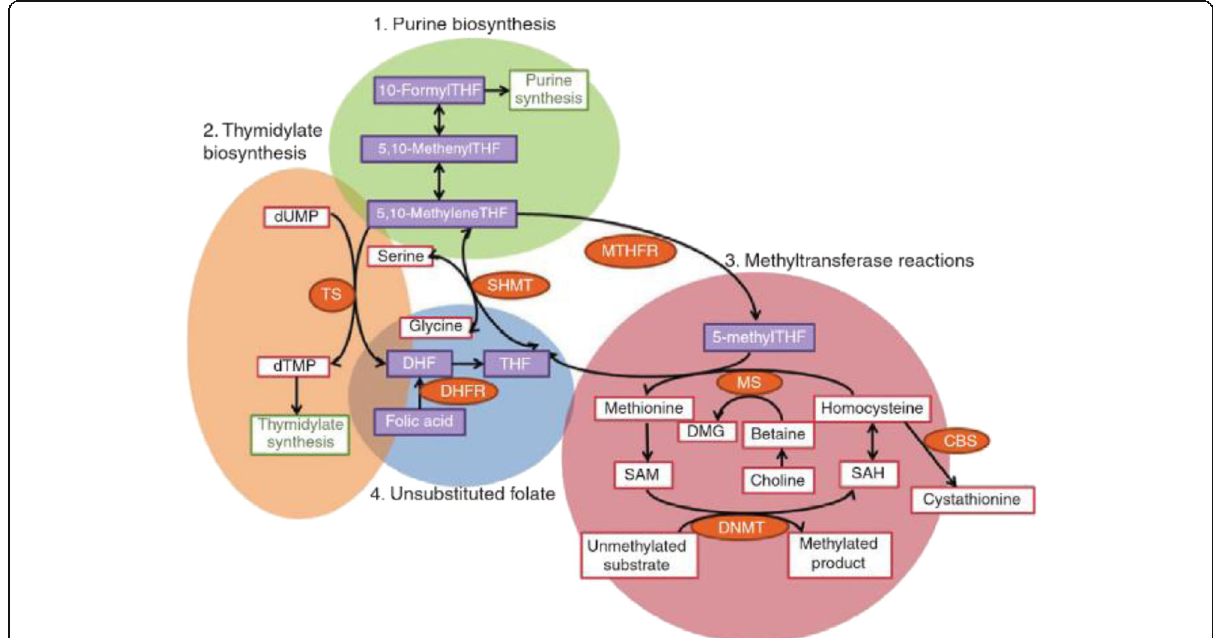
Fig. 2 Intracellular network of reactions in the metabolism of folates. A variety of related compounds derived from folic acid have specific biochemical functions. Folic acid is first converted into dihydrofolate ( DHF ) and subsequently into tetrahydrofolate ( THF ) by the enzyme DHF reductase ( DHFR ). 5,10-methyleneTHF and 10-formylTHF are responsible for the synthesis of purines; 5,10-methyleneTHF also mediates the conversion of dUMP to dTMP for the synthesis of thymidine, catalysed by the enzyme thymidine synthase ( TS ). 5-methylTHF is involved for methylation reactions, particularly in the conversion of homocysteine to methionine for the formation of SAM, a major methyl donor for DNA (figure taken from